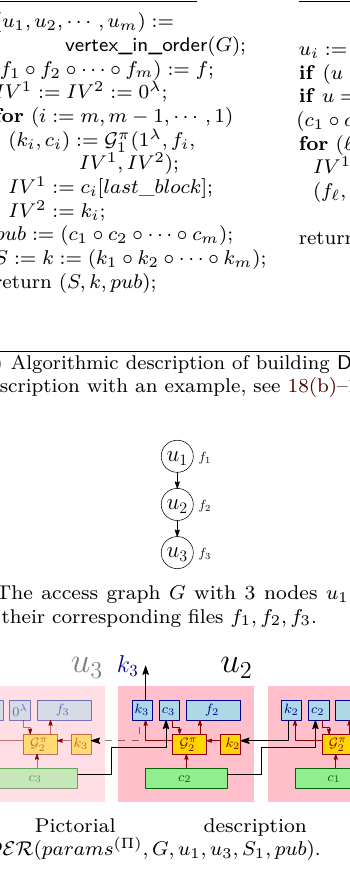
Figure 18: Building D Chain